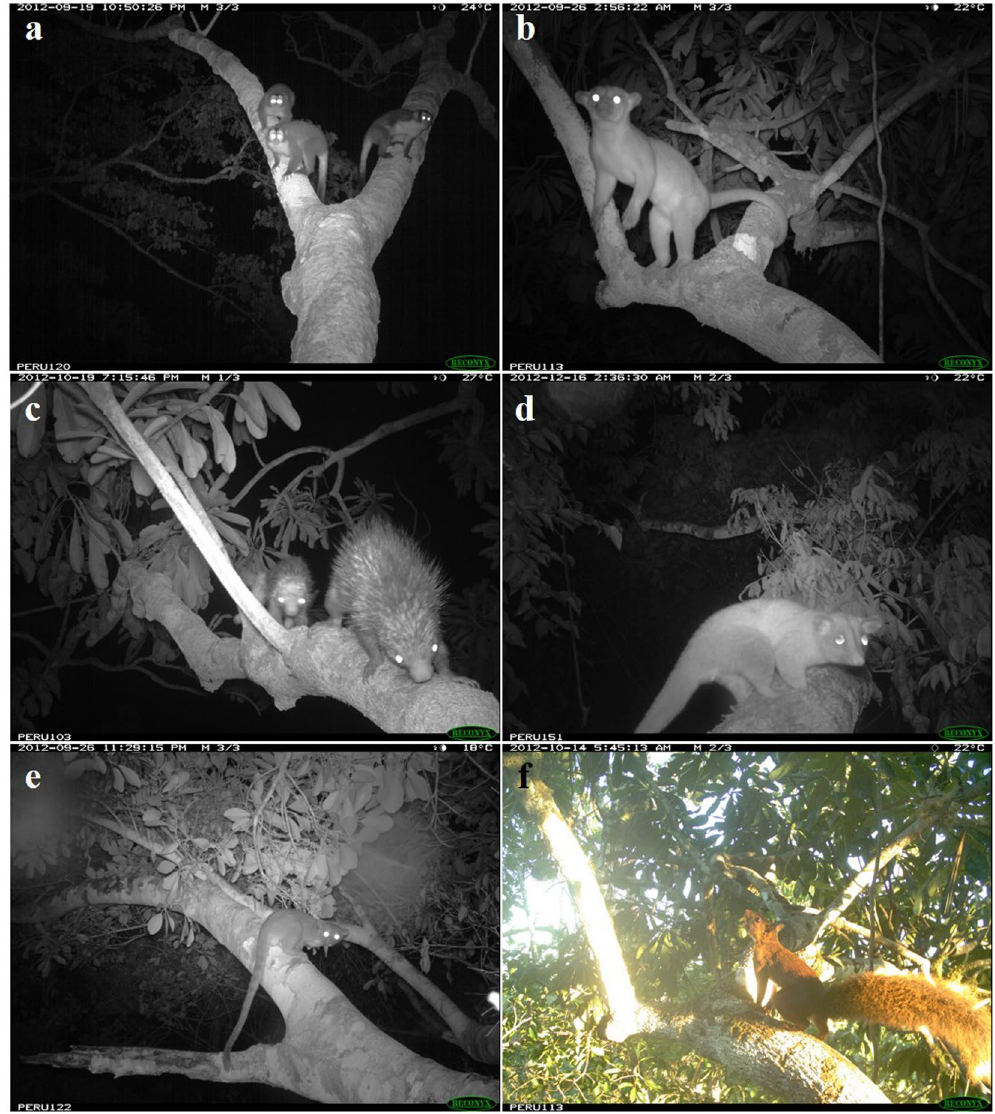
Figure 1. The six species that most frequently used the 13 natural canopy bridges over the pipeline clearing: ( a ) Aotus nigriceps , ( b ) Potos flavus , ( c ) Coendou ichillus , ( d ) Caluromys lanatus , ( e ) Bassaricyon alleni , and ( f ) Hadrosciurus spadiceus